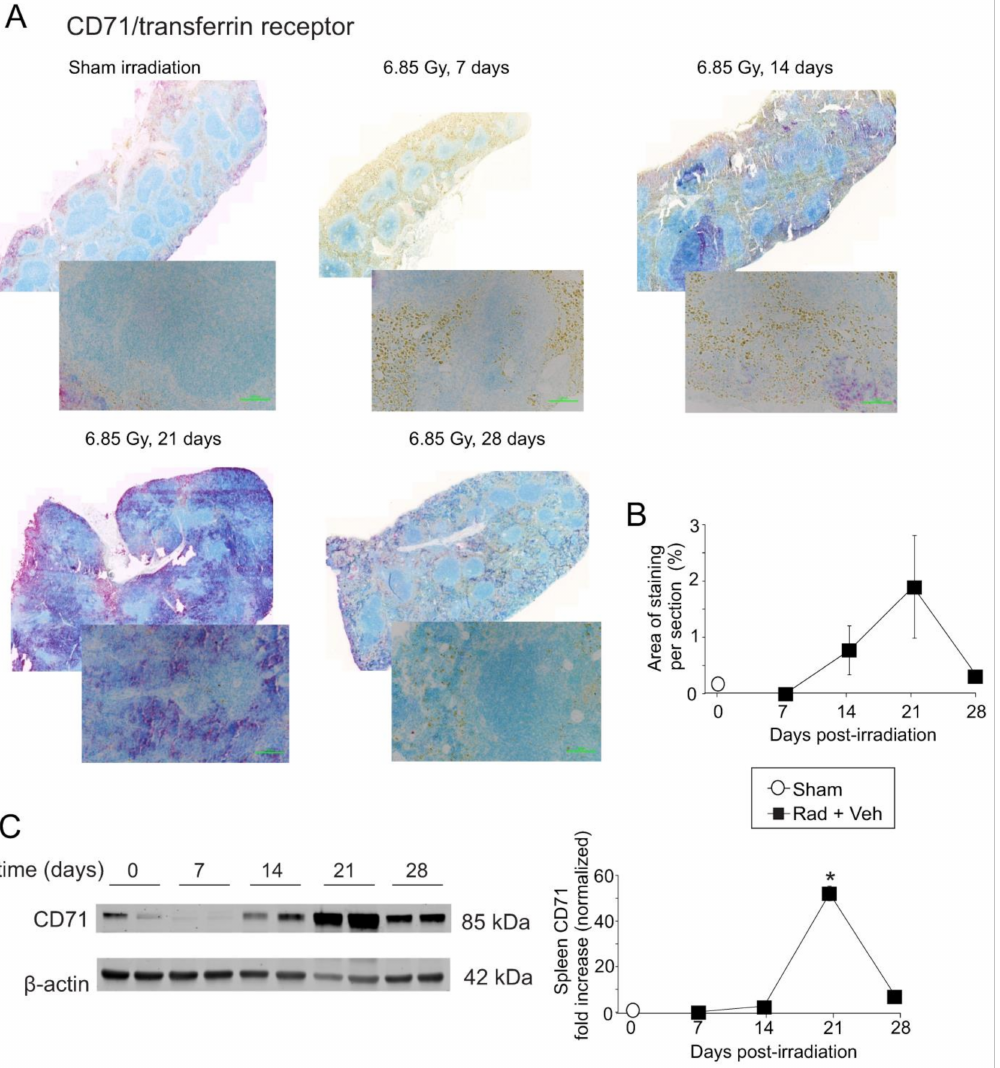
Figure 6. Total body irradiation results in increased transferrin receptor/CD71 in the spleen. C57BL/6 mice were exposed to 6.85 Gy total body irradiation. At the indicated time points, mice were euthanized, and spleen tissue was obtained for immunohistochemistry and western blotting. ( A ) Spleen sections were stained for transferrin receptor/CD71. Whole spleen images are shown from the Ziess Axioscan. Representative images from 3 separate slides are shown in the high-powered (30 × ) magnification. ( B ) Quantification of transferrin receptor/CD71 IHC staining. Graph shows means ± SEM, n = 3. ( C ) Western blots of transferrin receptor/CD71 in total spleen tissue; blots were reprobed for β -actin as a loading control. Representative data are shown from n = 2 animals. Graph shows normalized means ± SEM, n = 4 animals; * indicates p < 0.05 from